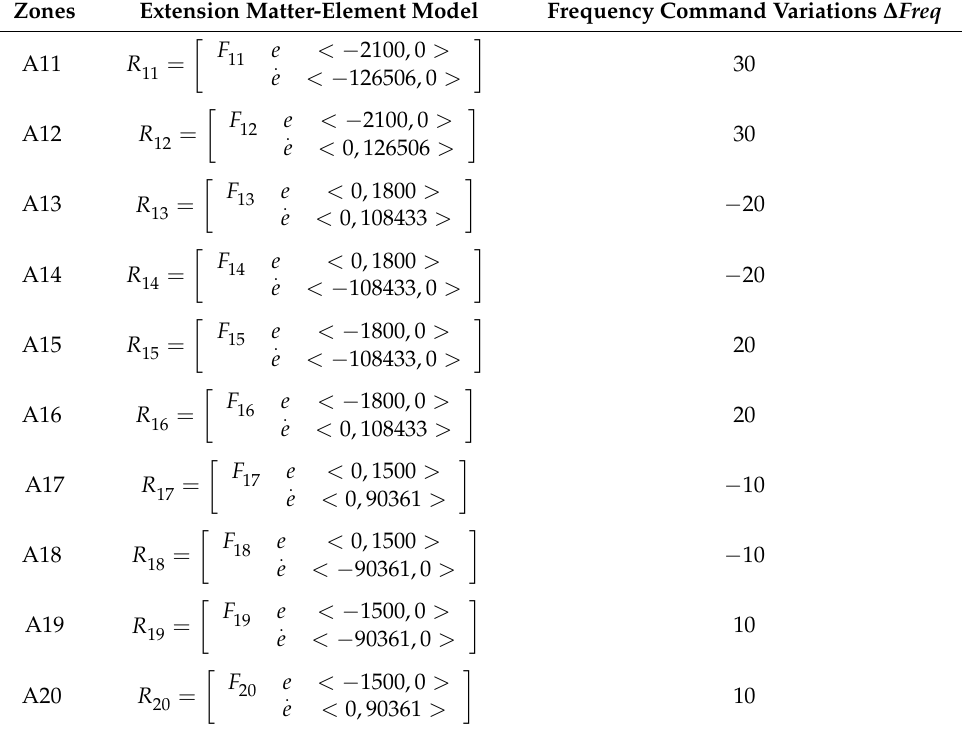
Table 2. Cont. Zones Extension Matter-Element Model Frequency Command Variations ∆